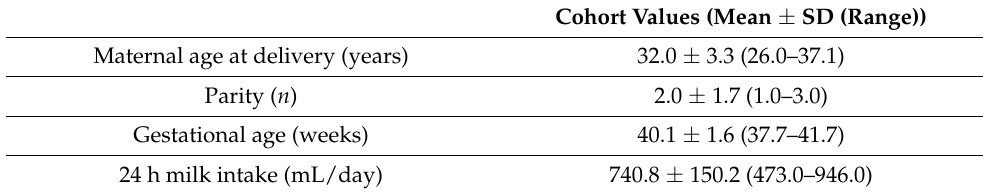
Table 1. Cohort characteristics of 18 mother–infant